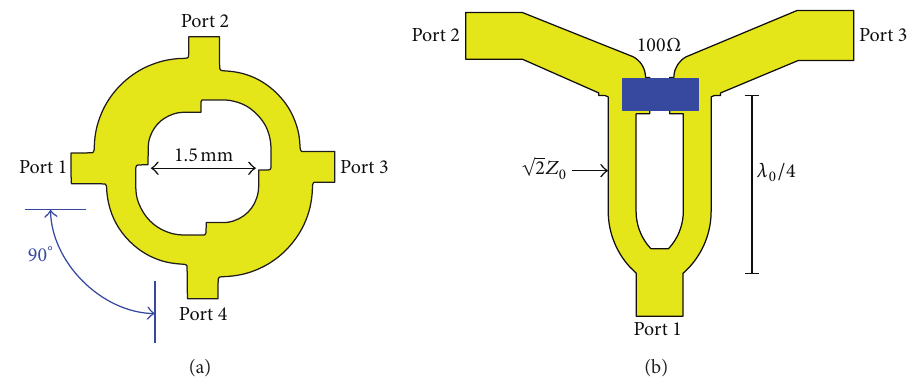
Figure 6: Layout of (a) 90 ∘ hybrid coupler and (b) Wilkinson power divider.